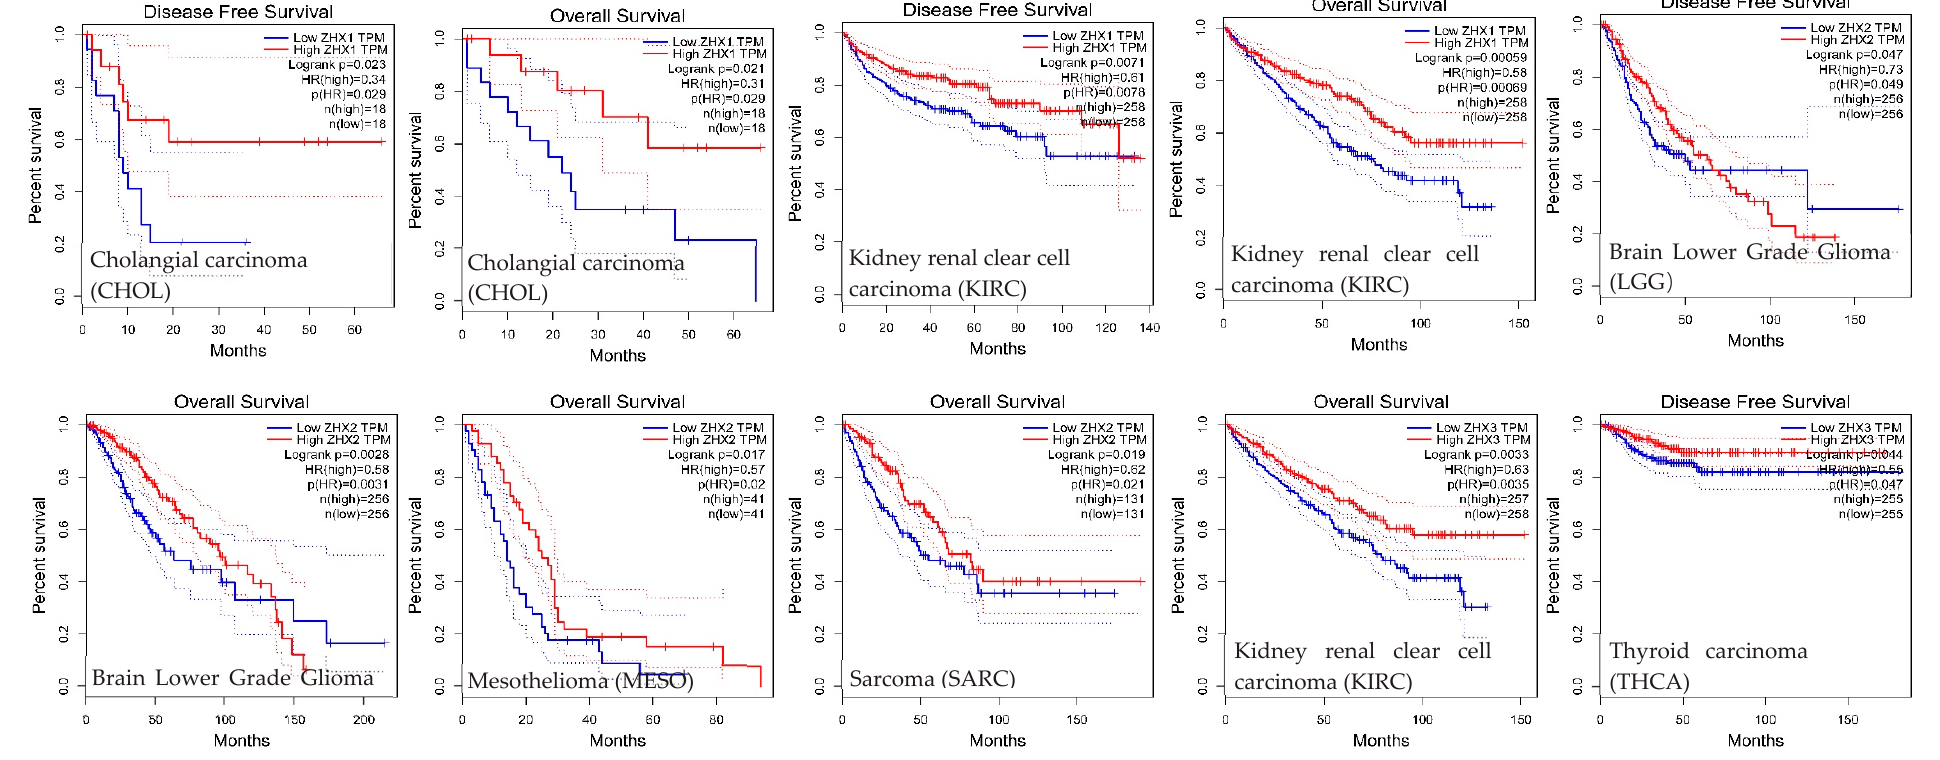
Figure 4. ZHX1, ZHX2, and ZHX3 gene expression level and survival analysis in 12 types of cancers. These panels were generated using the GEPIA database (http://gepia.cancer-pku.cn/) on 06/02/2022. ( A ): Patients with low ZHX1, ZHX2, or ZHX3 expressions have better OS or DFS. The words in red stood for ZHX1, ZHX2, and ZHX3 high expressions, the words in blue stood for ZHX1, ZHX2, and ZHX3 low expressions. ( B ): Patients with high ZHX1, ZHX2, or ZHX3 expressions have better OS or DFS. GEPIA performs overall survival (OS) or disease-free survival (DFS) analysis based on ZHX1, ZHX2, and ZHX3 gene expressions. The cox proportional hazard ratio and 95% confidence interval information can also be included in the survival plot. “Median” was used in group cutoff. Cutoff-high (%) indicates that samples with expression levels higher than this threshold are considered as the high-expression cohort and samples with expression levels lower than this threshold are considered the low-expression cohort. Cancer types of abbreviations: ACC, adrenocortical carcinoma; BLCA, bladder urothelial carcinoma;